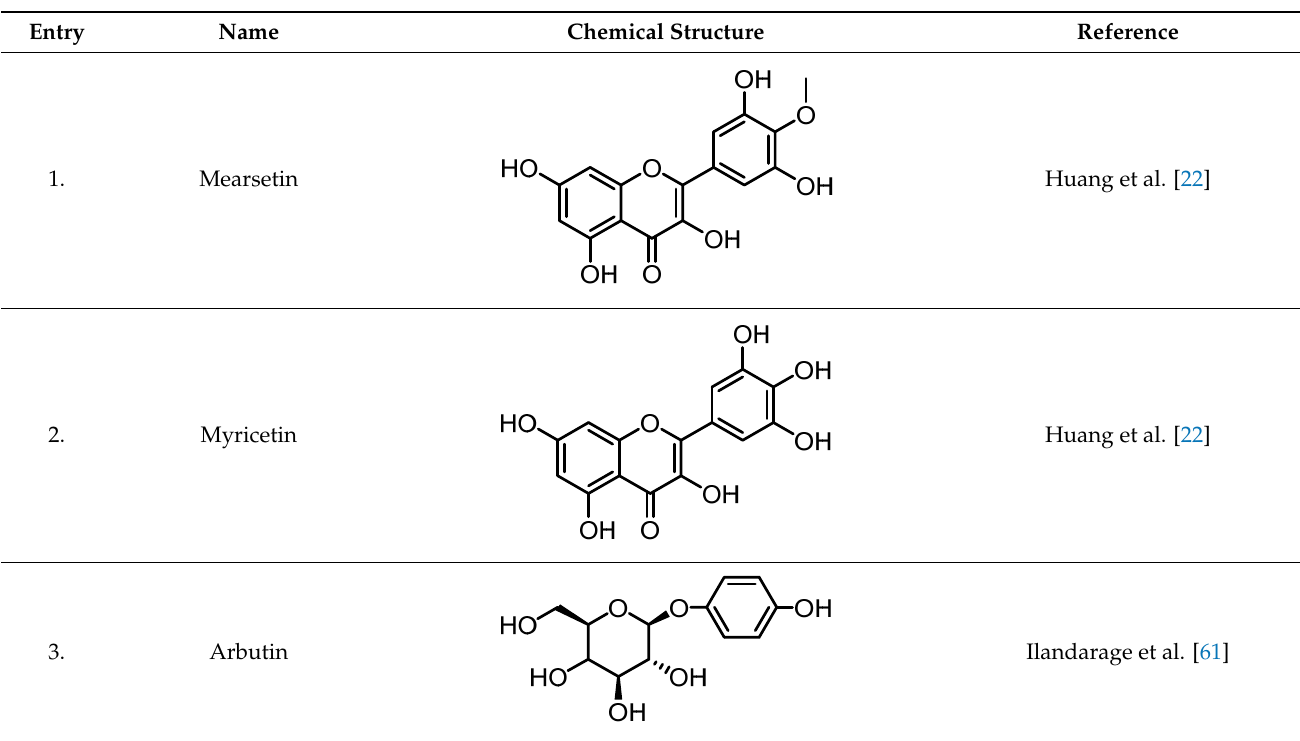
Table 3. Compounds and metabolites derived from plant species used as melanogenesis inhibitors in zebrafish embryos.